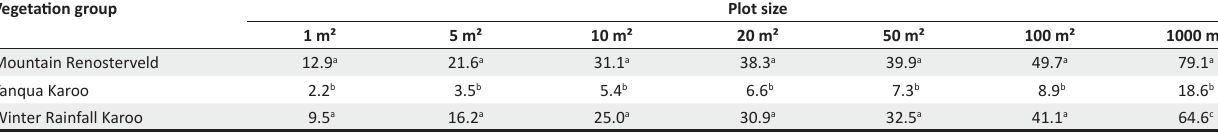
Within a column, values with the same superscript do not differ significantly at α = 0.05.